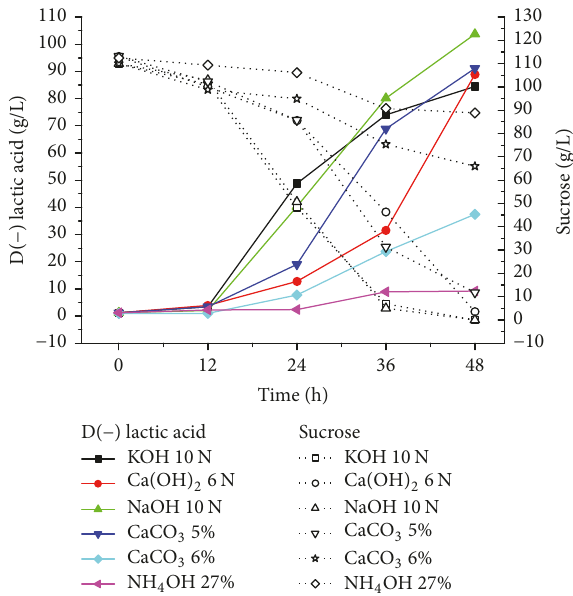
Figure 2: Time course of lactic acid and residual sucrose concen- tration using different neutralizing agents [KOH, Ca(OH) 2 , NaOH, CaCO, and NH 4 OH]. Culture conditions: GYP modified medium, 35 ∘ C pH 6.0, 10% (v/v) inoculums, 100